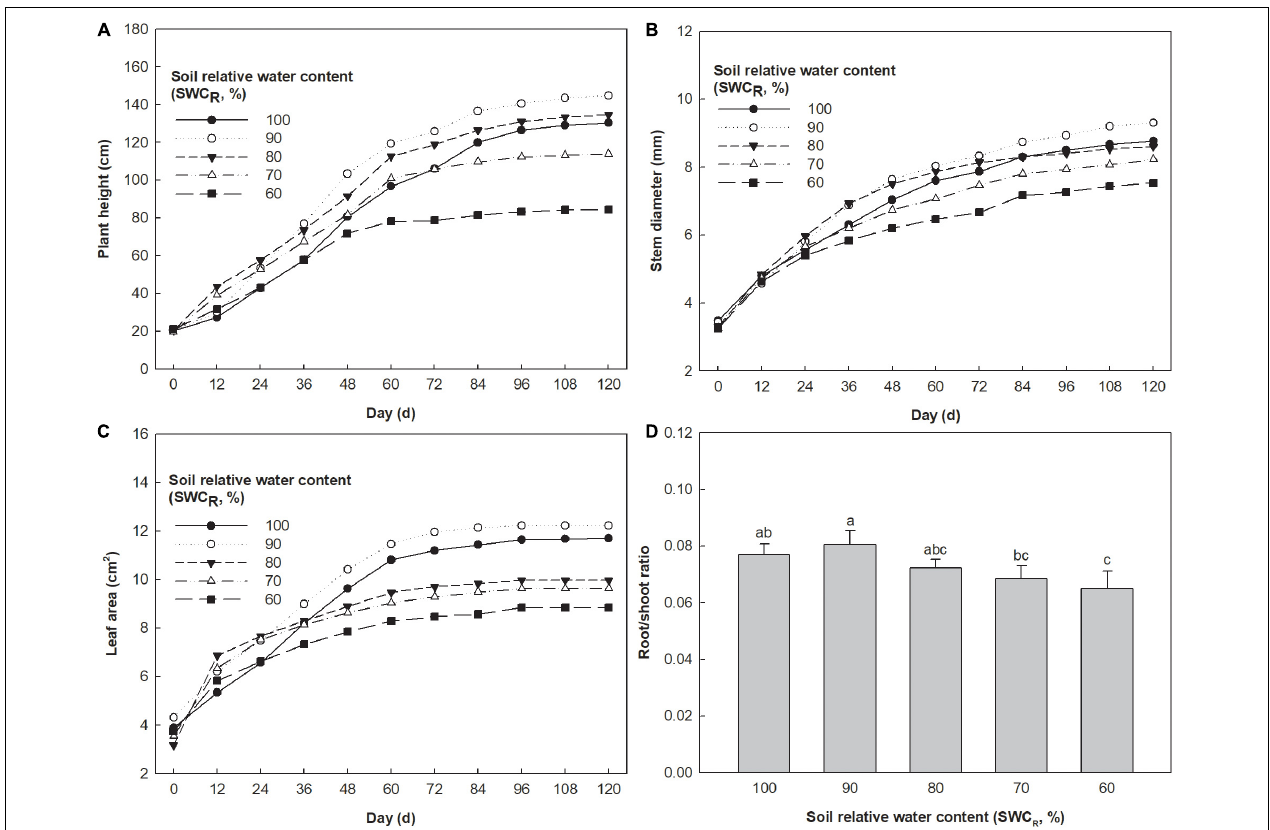
FIGURE 3 | Effect of different water supplies on plant height (cm), stem diameter (mm), and leaf area (cm 2 ) [ (A) Plant height; (B) stem diameter; (C) leaf area; (D) root/shoot (R/S) ratio. The means ( n = 5) followed by different letters in R/S ratio are significantly different ( p ≤ 0.05), according to one-way